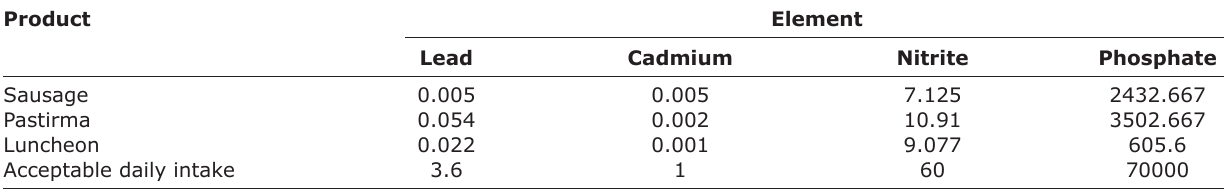
Table-5: The estimated daily intake of chemical contaminants in examined meat products (μg/kg bw/day).